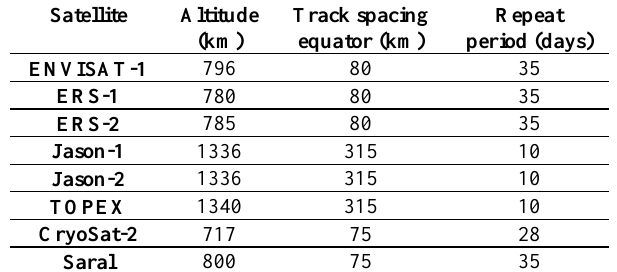
Table 5. Satellite Altimeter Mission Parameters